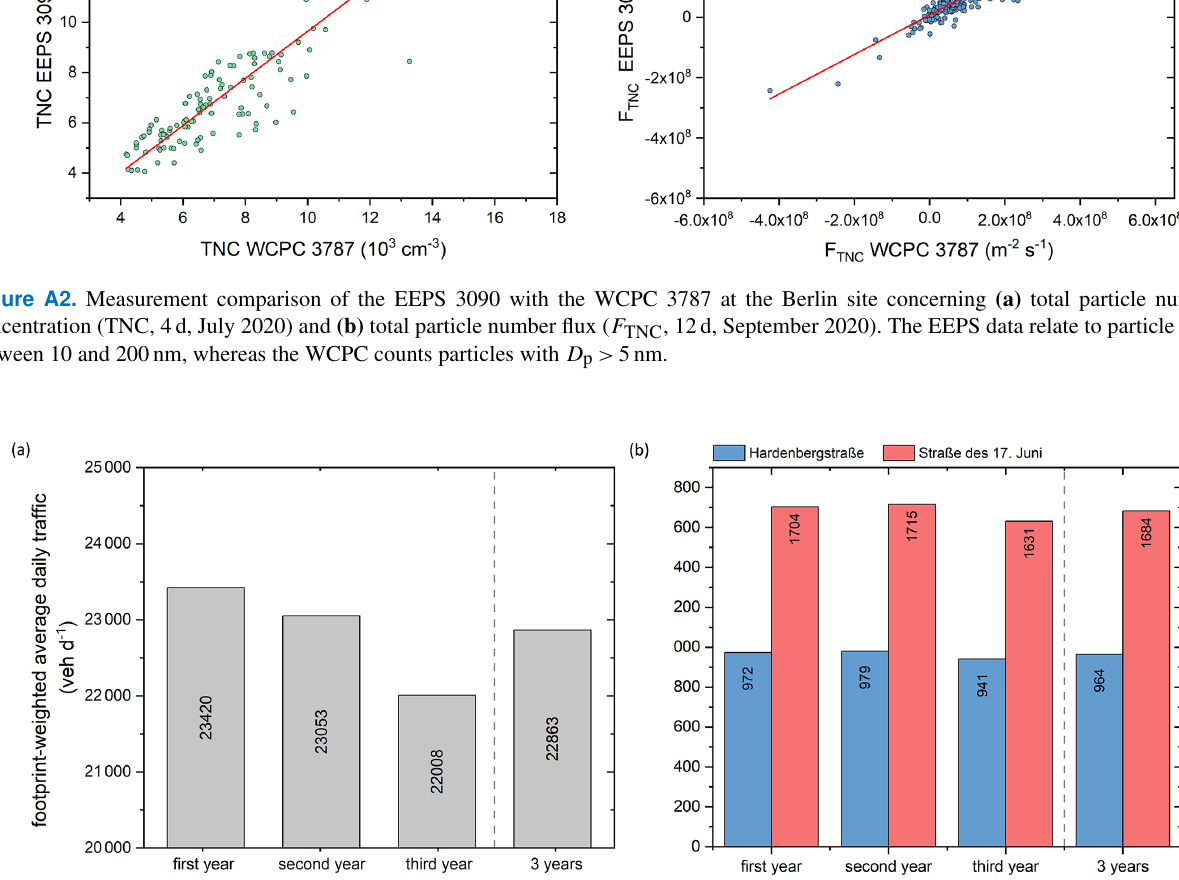
Figure A3. (a) Footprint-weighted average daily traffic intensity (data source: Umweltatlas, 2017) and (b) average traffic intensity measured at the two traffic counting stations, Hardenbergstraße (HS) and Straße des 17. Juni (S17J), for the entire measurement period and each observation